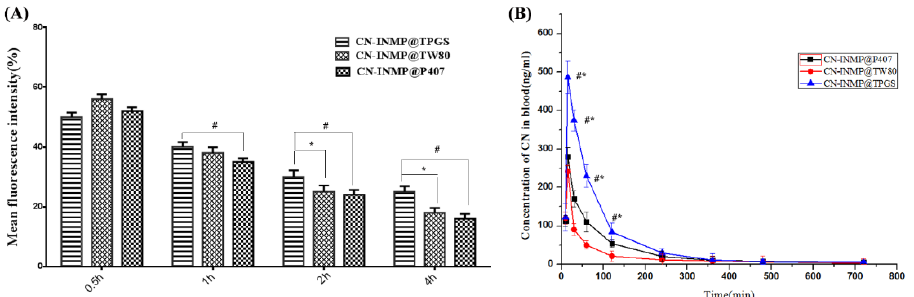
Figure 9. ( A ) the retention of CN in lung after pulmonary administration of tested CN-INMPs from 0.5 h to 2 h, and ( B ) the concentration of CN in blood after pulmonary administration of tested CN- INMPs. # The significance ( p < 0.05) between CN-INMP@TPGS and CN-INMP@P407 formulation. *